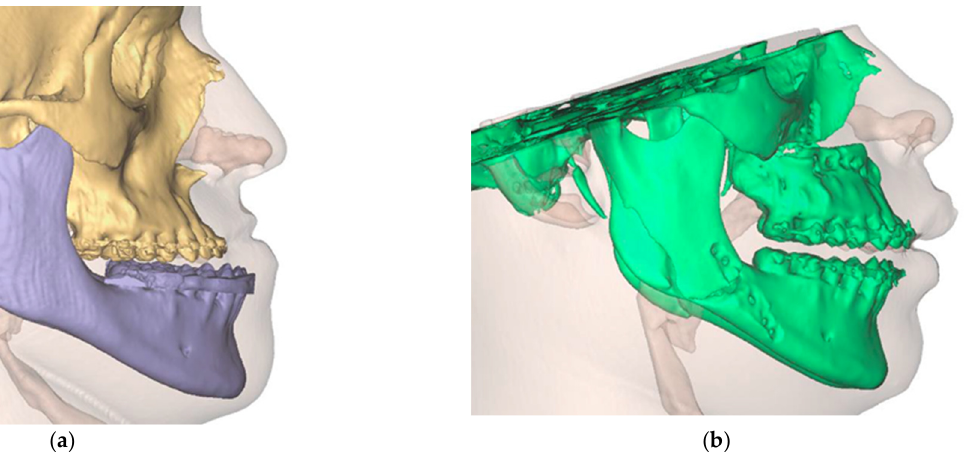
Figure 14. Visualization of the preoperative soft tissue profile ( a ) as well as the altered postoperative soft tissue profile ( b ).